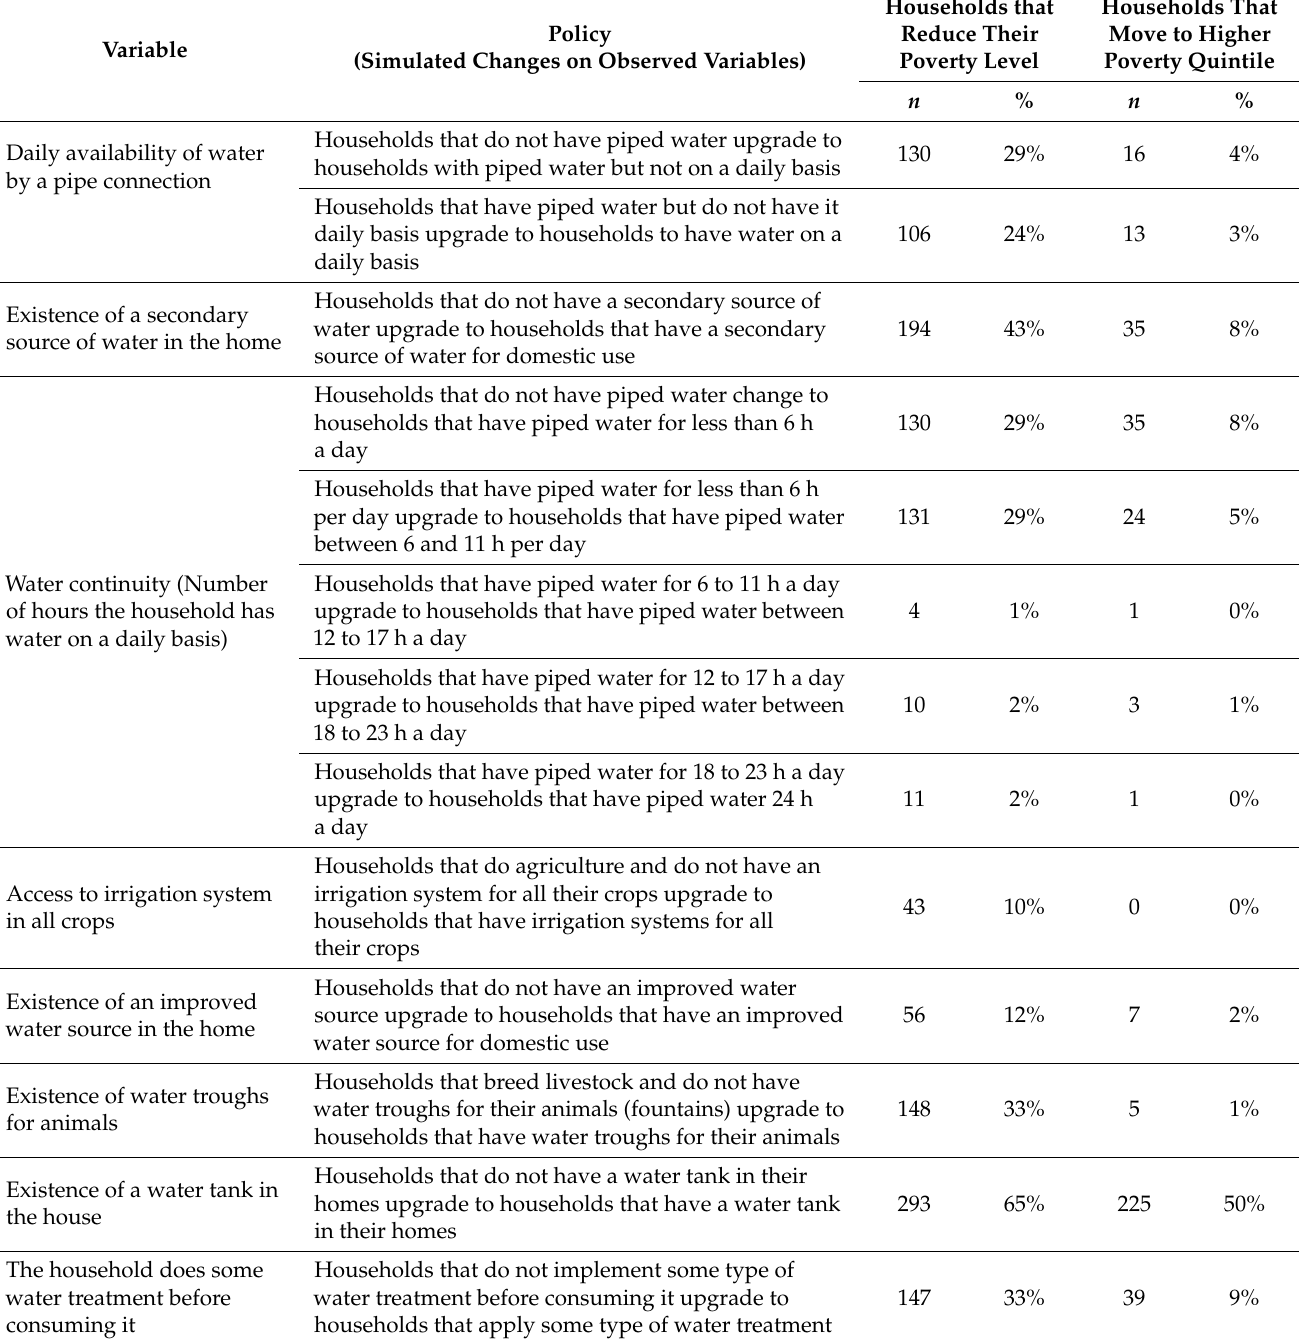
Table 10. Effect of water policies on the level of multidimensional poverty in the rural area of the Tupiza River